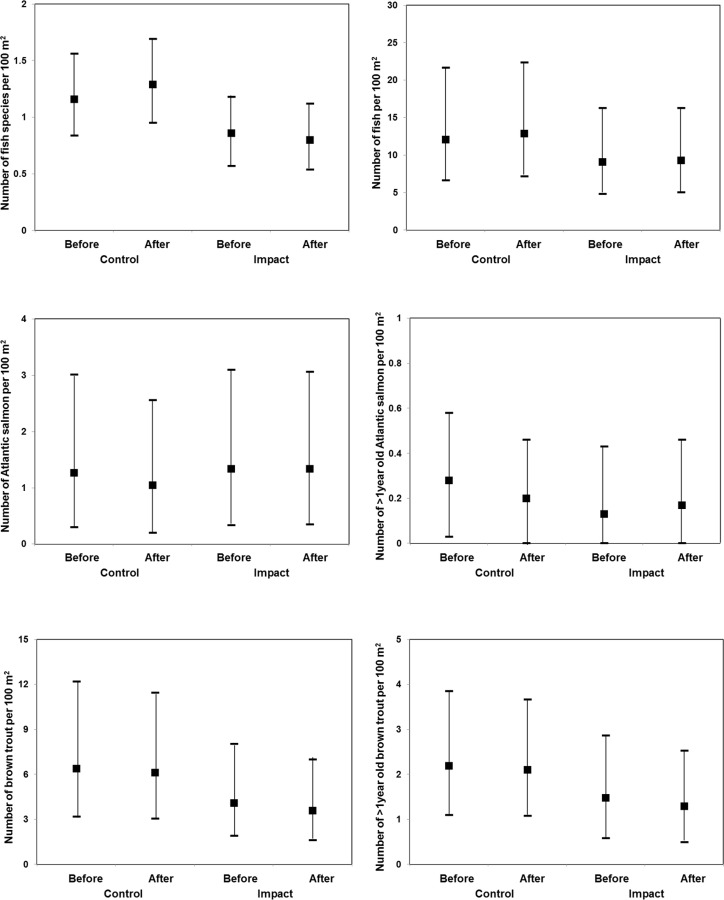
Fitted (least square) mean before and after values for the six area-normalised metrics of fish community composition for control and impact groups.Bars illustrate the upper and lower 95% confidence limits.